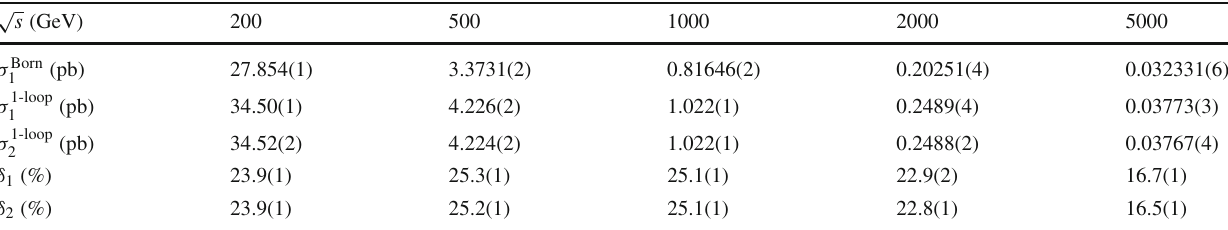
Table 4 Comparison of the Born and one-loop cross sections of the annihilation channel e + e − → Z γ(γ) calculated with different values of the soft/hard separation parameter ¯ ω ; for details see the text √